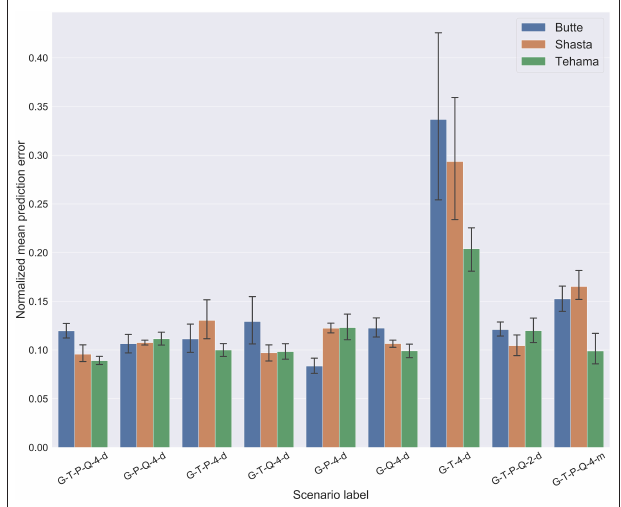
FIGURE 3 | Barplot comparing the normalized mean prediction error and their standard deviation at all well-sites for all experiments. The normalized values are obtained by dividing the error by the difference between the maximum and minimum observed groundwater levels ( 1 max ). This normalization helps us to compare model performance across different locations. Lower bars indicate smaller prediction errors and therefore better model performance. The errors were computed by comparing the true and predicted groundwater levels in the testing